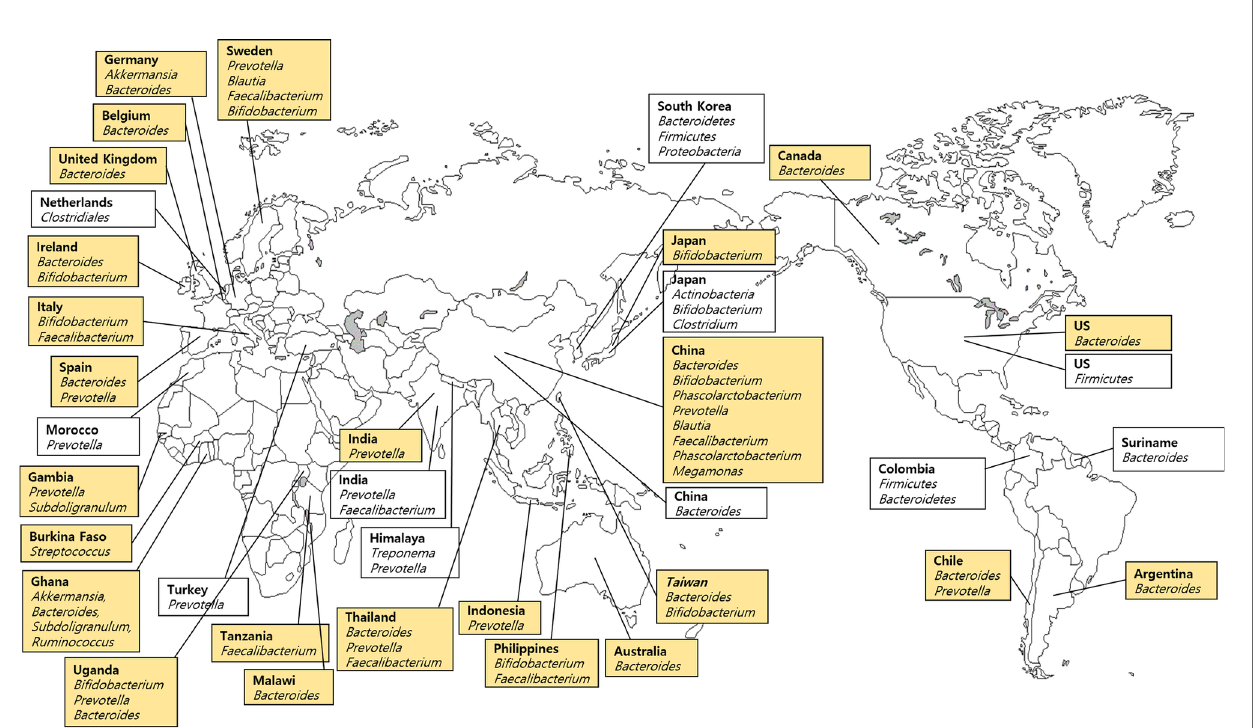
FIGURE 4 | Dominant bacteria in stool samples based on the Forensic Microbiome Database (www.fmd.jcvi.org) data and non-FMD studies. The yellow-colored box is from the FMD data, and only bacteria which account for over 10% are shown. Twenty- fi ve countries from the FMD and 11 countries from previous studies were included, and the microbiome pro fi ling was generated using 16S rRNA gene